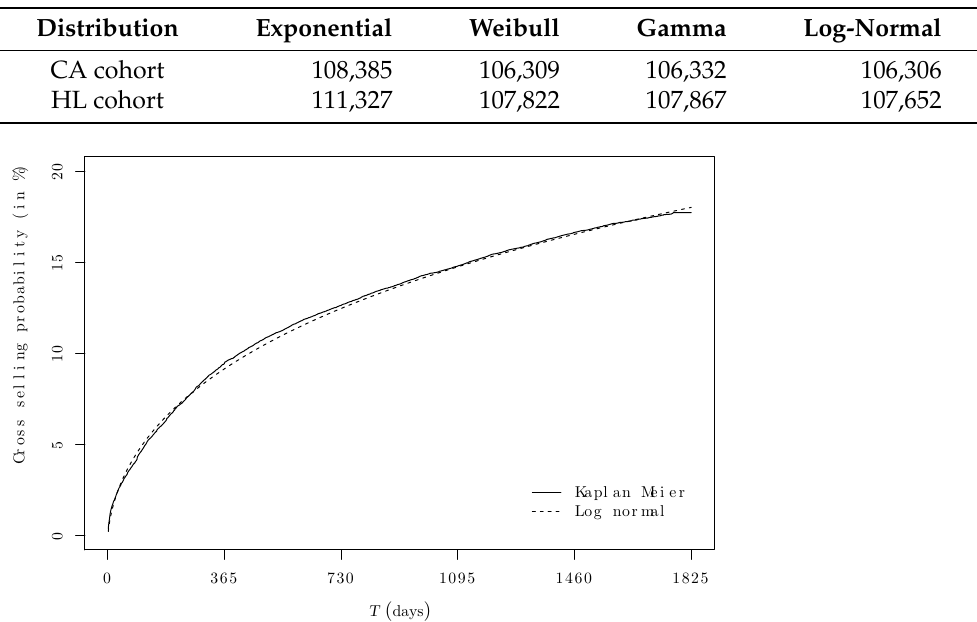
Figure 9. Kaplan–Meier estimates for the cross-selling probability and log-normal distribution fit for the HL